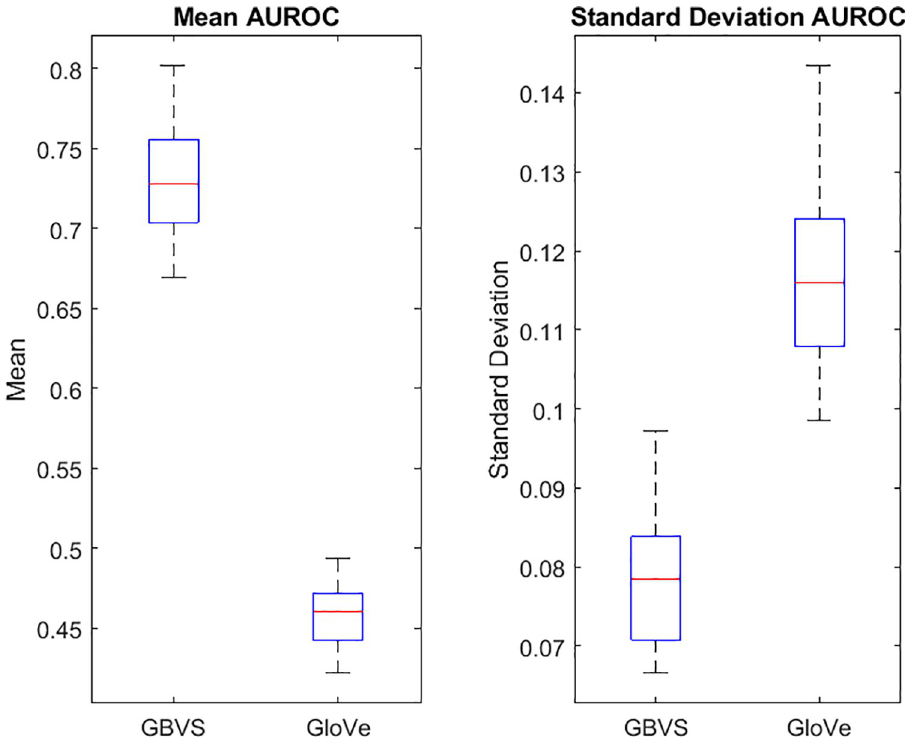
Fig 4. Mean and standard deviation of AUROC for each model. AUROC is averaged across all subjects and N-back levels for each subject. Box and whisker plots show the distribution of AUROC for each model, red lines show median, boxes show interquartile range and whiskers show 95% confidence